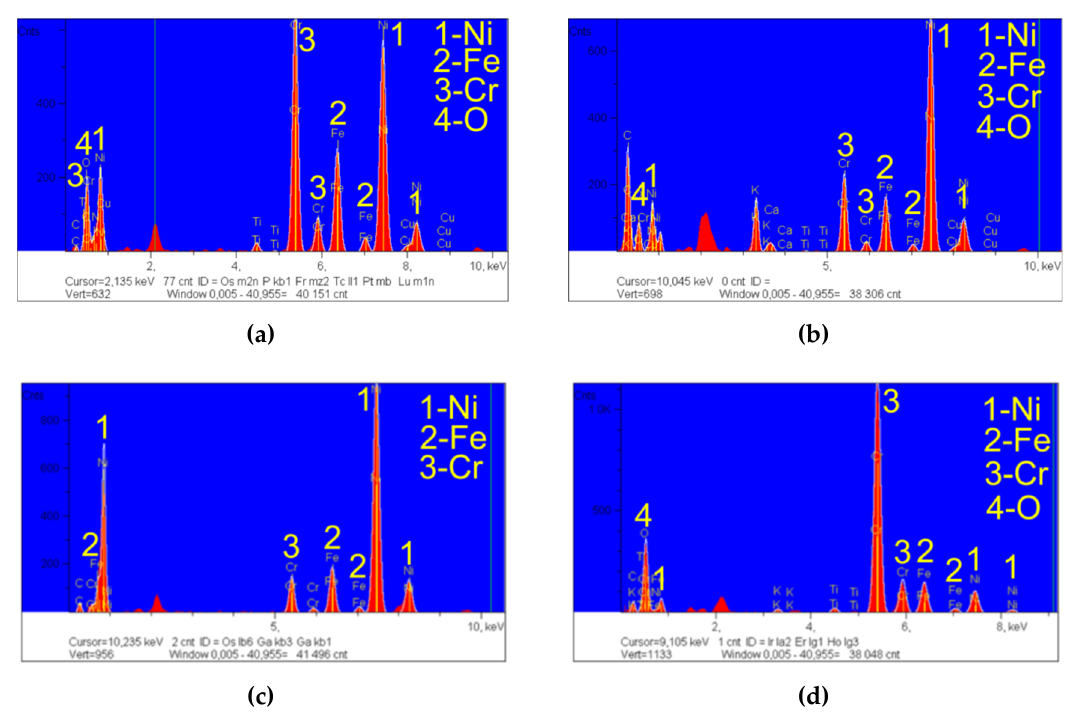
Figure 15. The chemical composition of the internal surface of the hole as determined by EDS. ( a ) In Zone I; ( b ) at point 1; ( c ) at point 2; and ( d ) at point 3. Zone I; ( b ) at point 1; ( c ) at point 2; and ( d ) at point